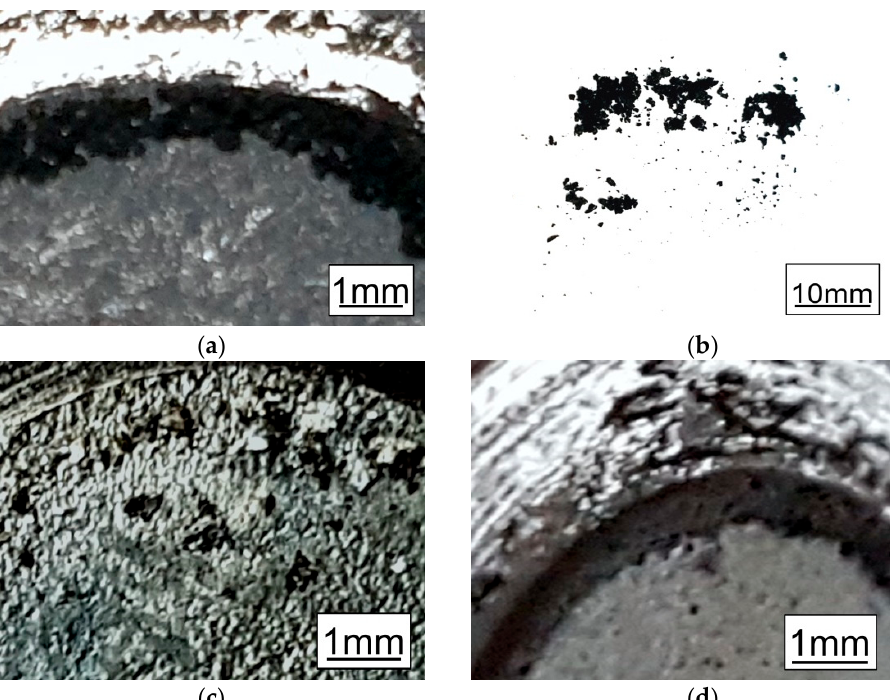
Figure 8. The appearance of the coatings’ outside surface and friction products observed after the pin-on-disc friction test: ( a ), ( b ) sample TD30; ( c ) sample HDUT; ( d ) sample HD HT at 430 °C.